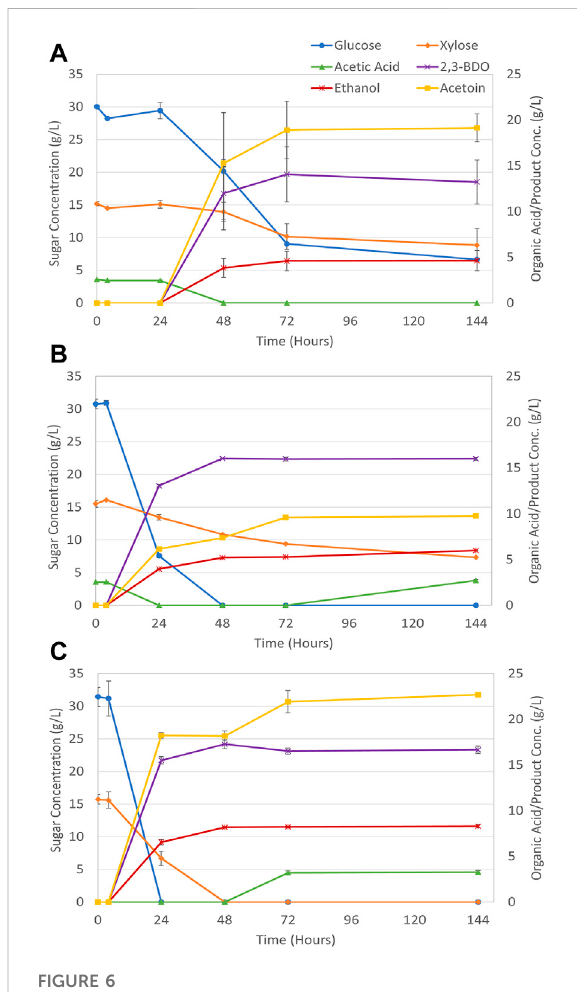
FIGURE 6 P . polymyxa sugar consumption and product generation during oxygen limited fermentation of (A) raw SSB hydrolysate, (B) 1:1 (v/v) raw/detox SSB hydrolysate, (C) detoxi fi edSSB